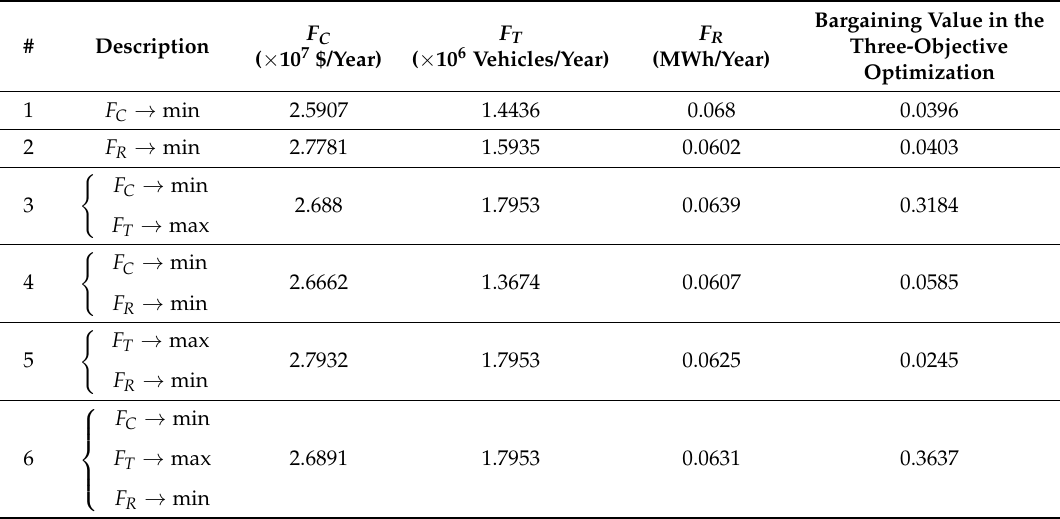
Table 4. Planning results comparison with different modeling